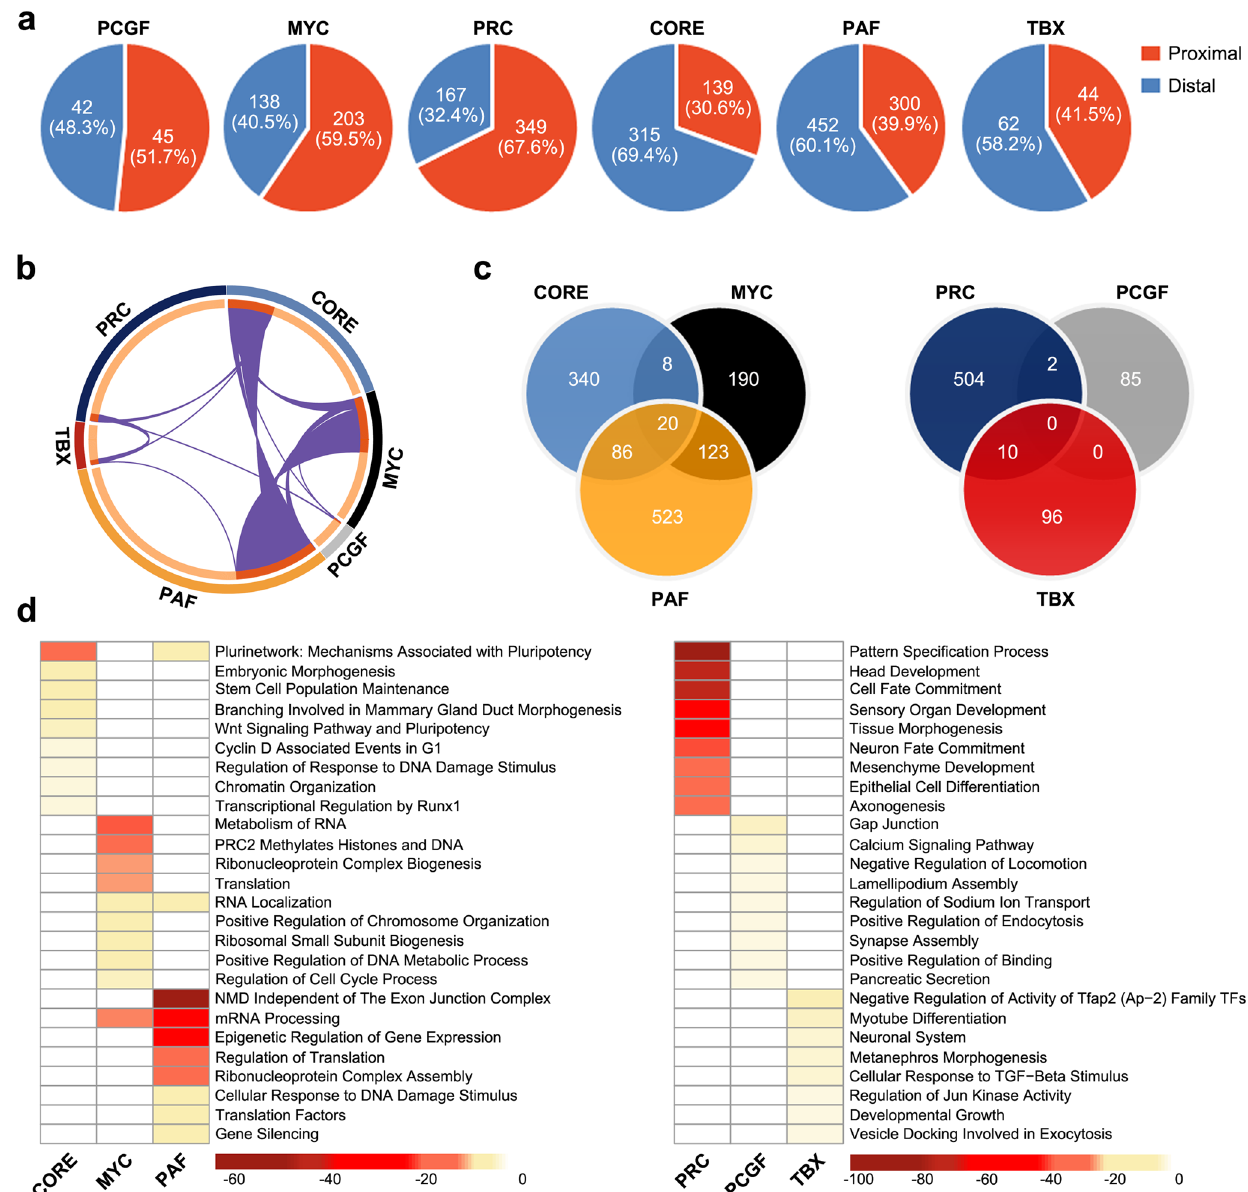
Fig. 6 Gene composition and functional enrichment analysis of each module. a The percentage of proximal and distal target genes de fi ned by AdaEnsemble (see Method section) in each module. b Circos plot indicates the overlaps between module genes. The inner circle represents the gene lists of each module. Genes that hit multiple lists are coloured in dark orange, and genes unique to a list are shown in light orange. The purple curves inside link identical genes. c Venn diagram demonstrating the gene numbers and overlaps in transcriptionally active modules (left) and transcriptionally repressed modules (right). d GO analyses of genes in transcriptionally active modules (left) and transcriptionally repressed modules (right) (Supplementary Data 10). The top10 enrichment terms in each module are shown. The cell colour corresponds to – log 2 ( p